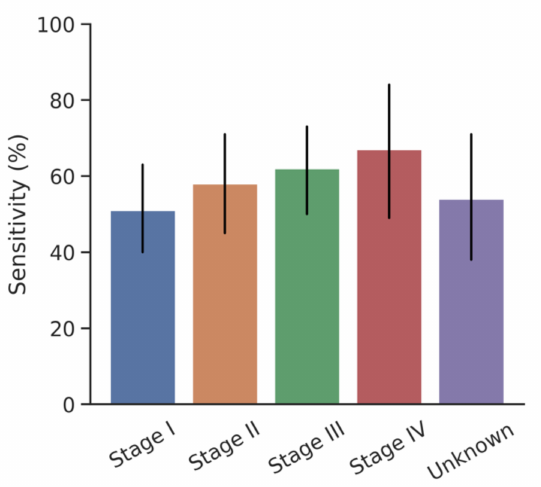
Figure 3. Sensitivity of DEEPGEN TM platform by cancer stage at 95% specificity.